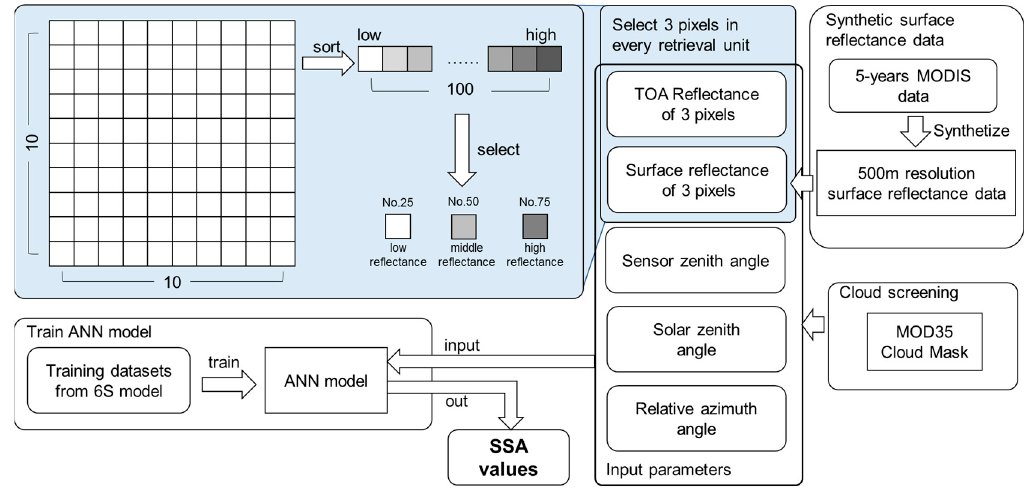
Figure 2. Flow chart of data preprocessing and SSA retrieval algorithm details.